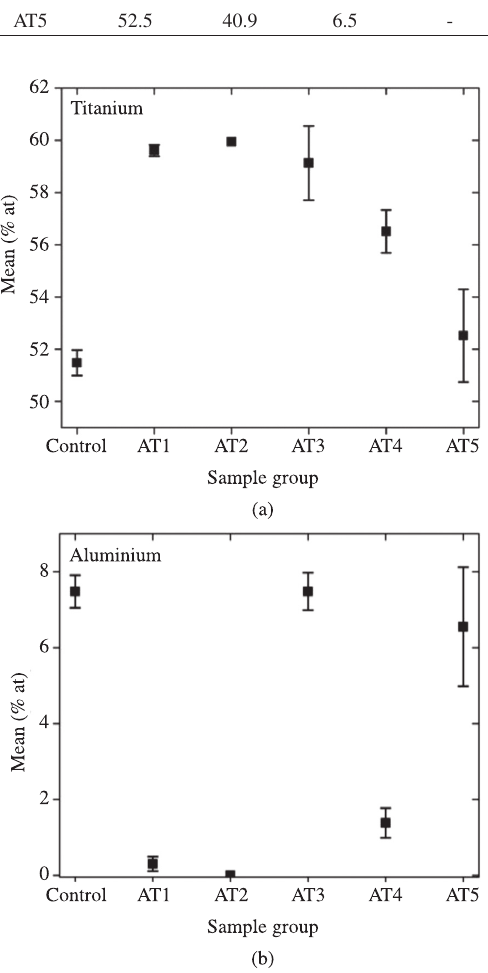
Figure 2. Graphic presentation of atomic concentration of titanium (a) and aluminium (b) in the sample groups, as determined by EDS